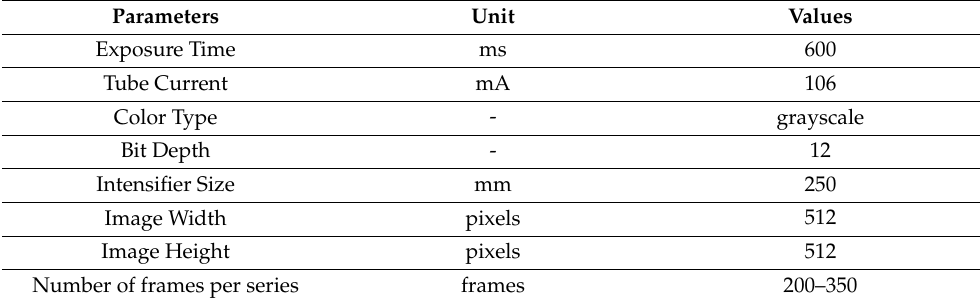
Table 1. Parameters of CT scan acquisition .